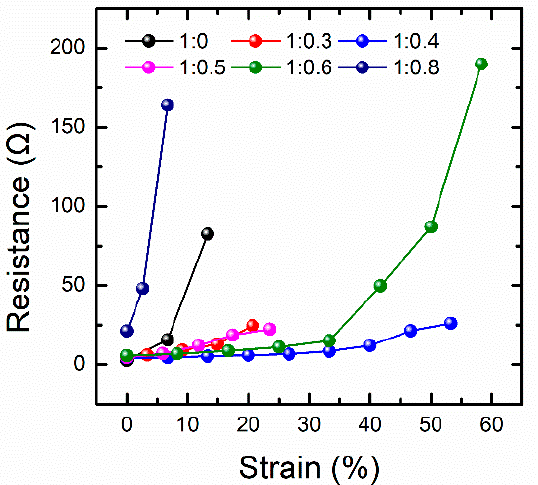
Figure 4. Comparison of the conductive performance of the electrodes with different ratios of silver glue and PDMS during stretching.